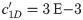
Pseudoglobal optimal solutions (markers) are compared to a large dataset for Belgian Malinois dogs.(A) A slowly decaying duty factor with increasing speed is predicted well by the model for medium to fast speeds, using c1D′=3E-3. At slow speeds, the model remains constant, slightly above impulsive predictions, while the empirical data approaches 1. A swing duration of half the natural pendular period (Tn) of the leg (Eq 31) does not explain the discrepancy. 95% CI for empirical mean duty factor is shown as a thin dotted line. (B) The optimal phase offset matches empirical values well for walking and trotting speeds, and the optimal walk-trot transition is very close to the natural transition speed. However, the model does not transition to a gallop after the natural trot-gallop transition speed (C) Hind Lag (HL) and Fore Lag (FL) is shown against speed. A perfectly symmetrical gait would have HL = FL = 0.5; walking and trotting in dogs is highly symmetrical both naturally [50] and in the model. Galloping is an asymmetrical gait, and past the trot-gallop transition, the lowest-cost gait discovered by the model becomes asymmetrical. Empirical phase offsets are mean values for each gait. All empirical data from [40].